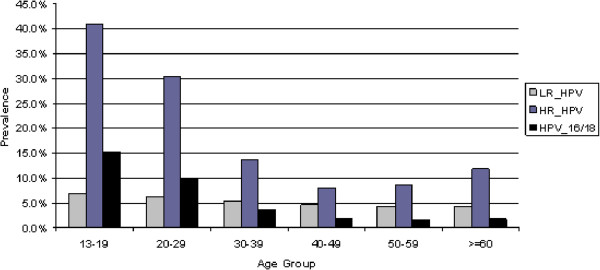
Proportion of HPV types by agegroup, in NWT, Nunavut, Labrador and Yukon, Canada.